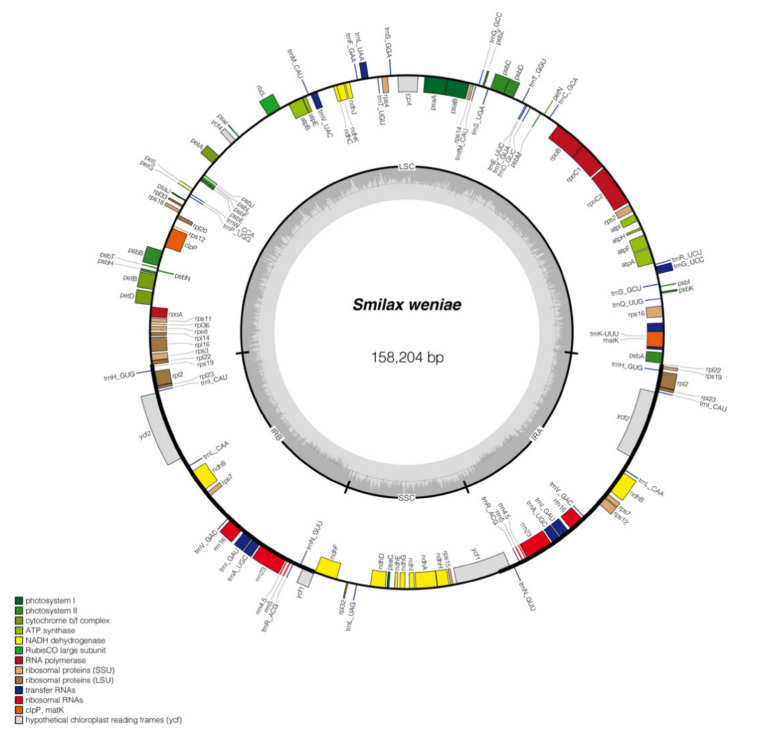
Figure 6. Plastome map of Smilax weniae . The inner dark gray circle corresponds to GC content and the inner light gray circle corresponds to the AT content. Different colors are used as a representation of distinctive genes within separate functional